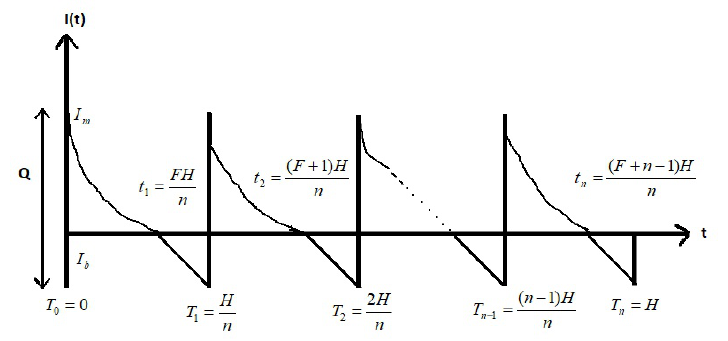
Figure 1. Inventory control